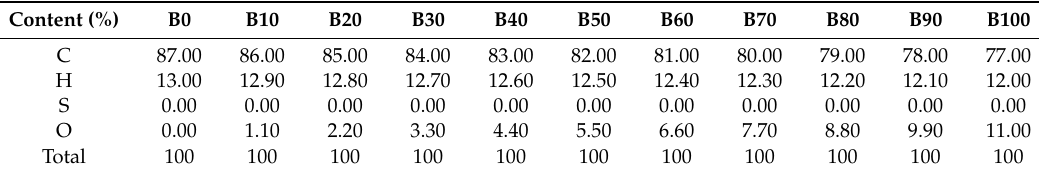
Table 4. Compositions of the mixtures according to their percentage of